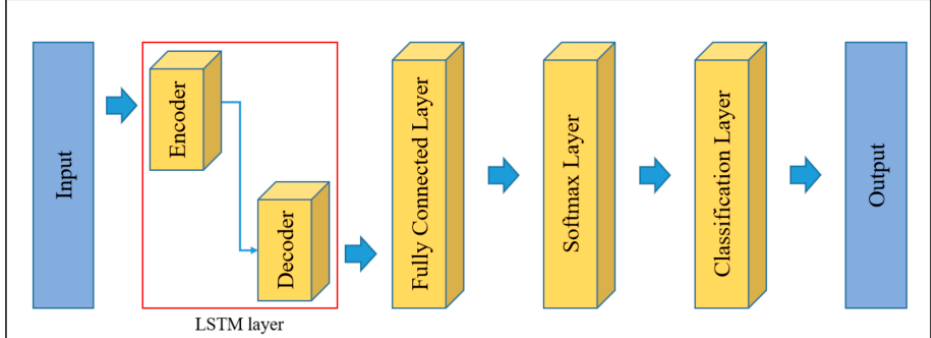
Figure 4. Model construction.